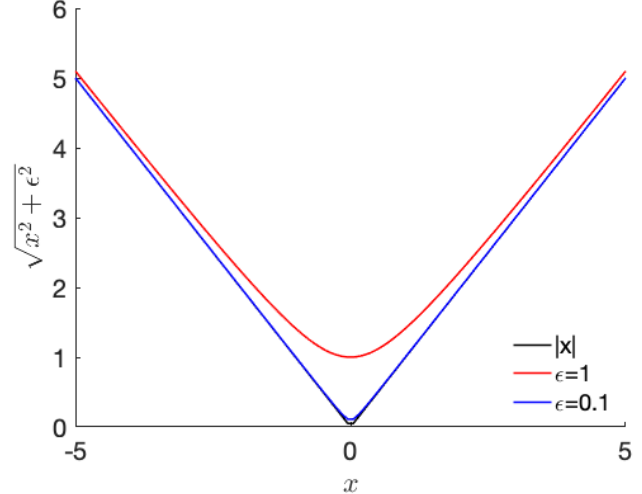
Figure 2. Example of the change in the smoothness due to the variation in (cid:101)